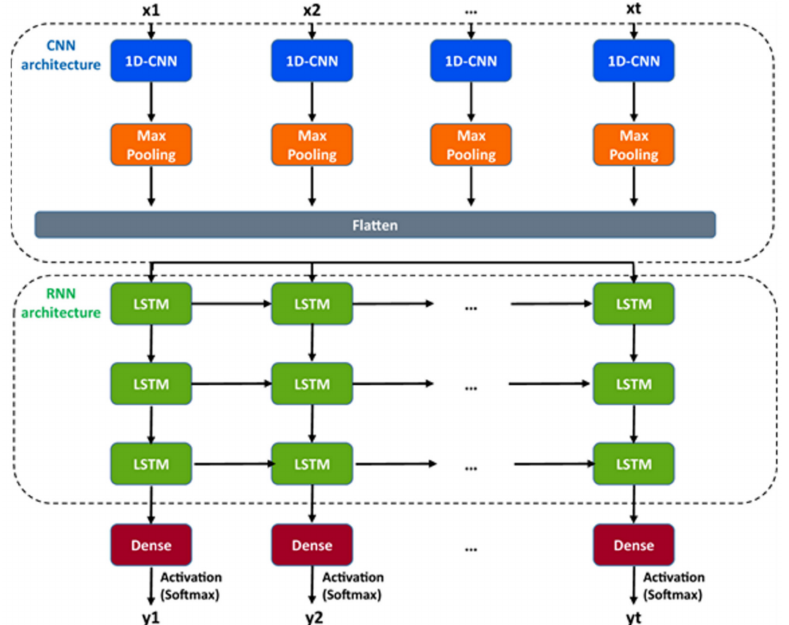
Figure 11. The data of the input time series were fed to the layer of the 1D Convolution (1D-CNN) including 1D convolution, and max pooling layers. Then the data was flattened to next network layer shape, an LSTM. 3 LSTM layers got stacked, each containing 256 LSTM units. The dropout layers got appended with all of the LSTM layers, having the value 0.2 to reduce overfitting. This returned features from the stacked LSTM layers. For additional details of the flowchart readers may go through the ref. article.